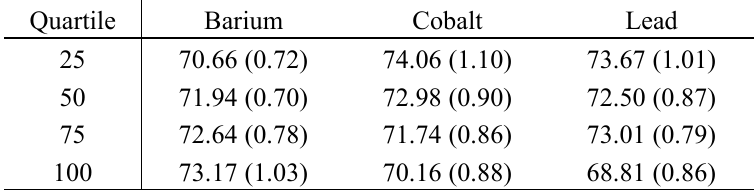
Table 11. Waist Circumference by Metal Quartiles for Adolescents. Quartile Barium Cobalt Lead